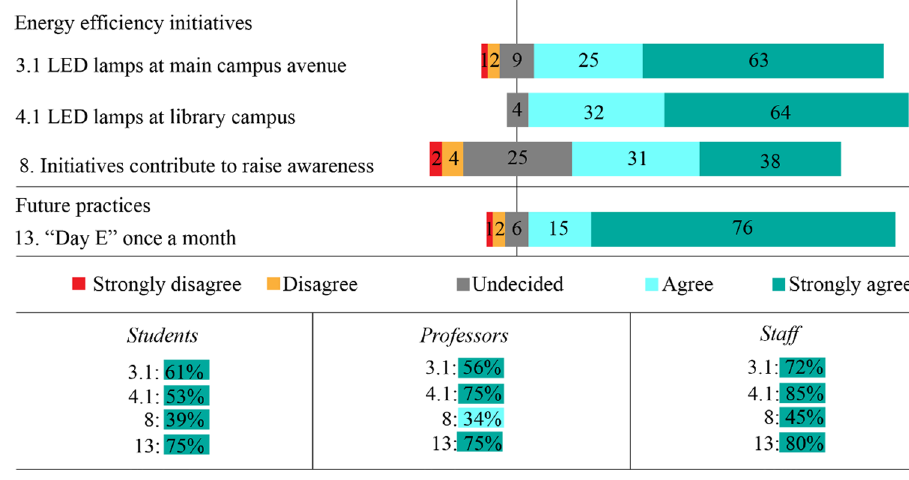
Fig. 2 Level of agreement of respondents when asked about energy initiatives and improvements in visual qual- ity and safety, visual comfort, awareness-raising and inten- tion to